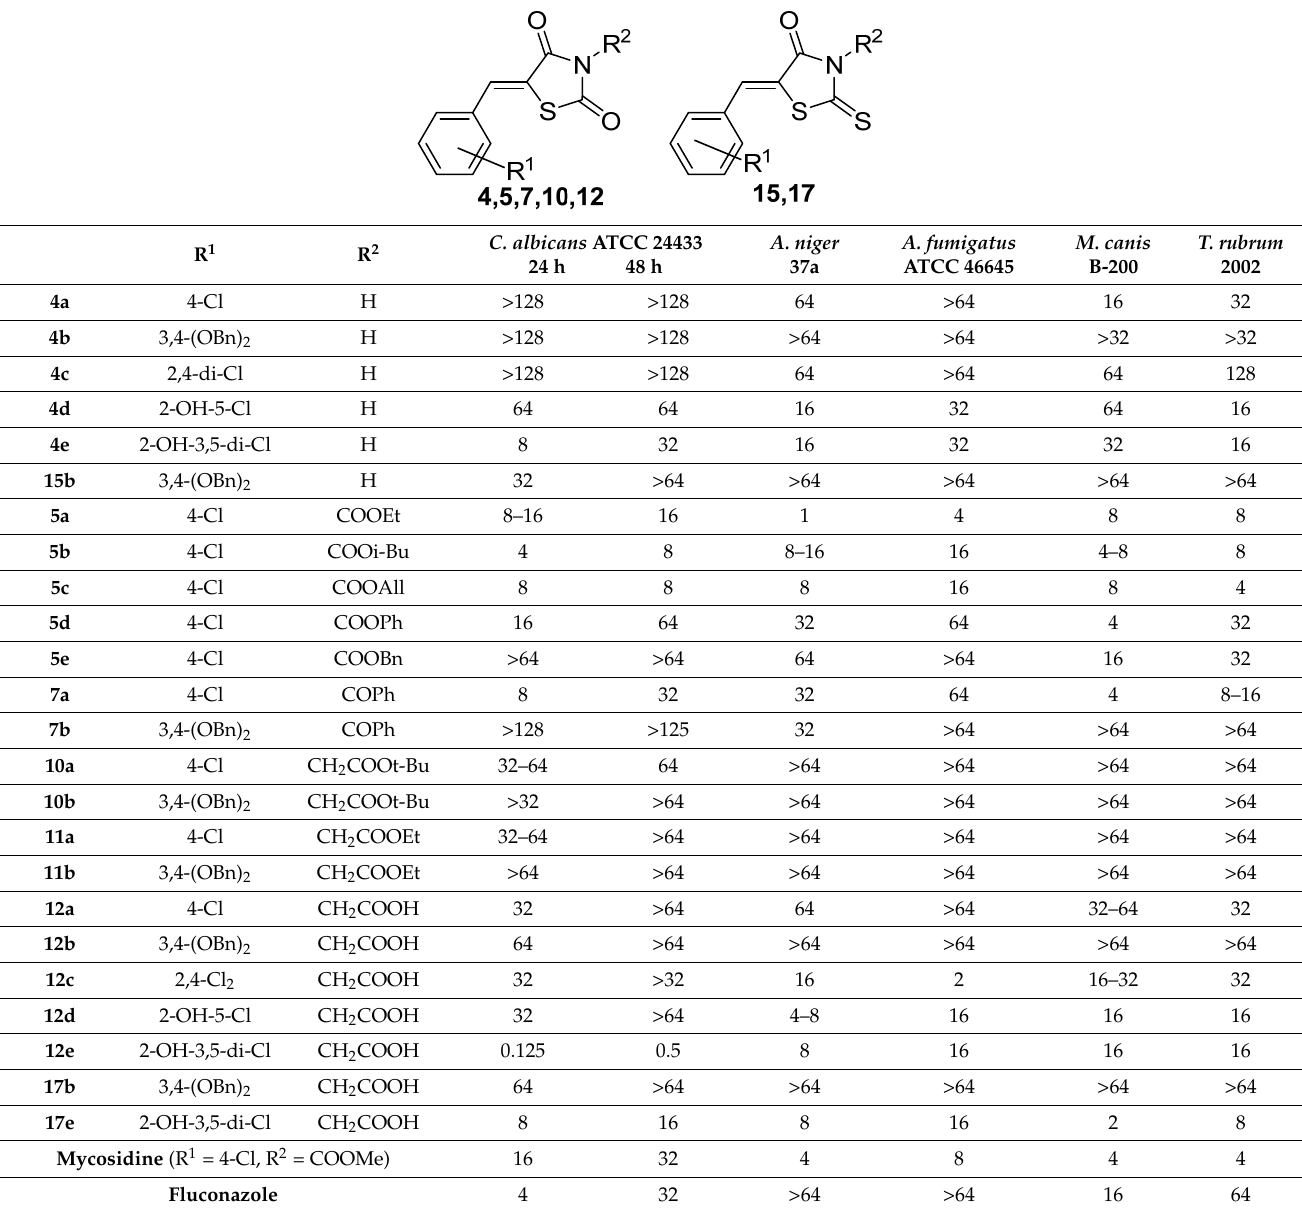
Table 3. Antifungal activity of synthesized compounds (MIC in mg/L). Experiments were performed at least 3 times.